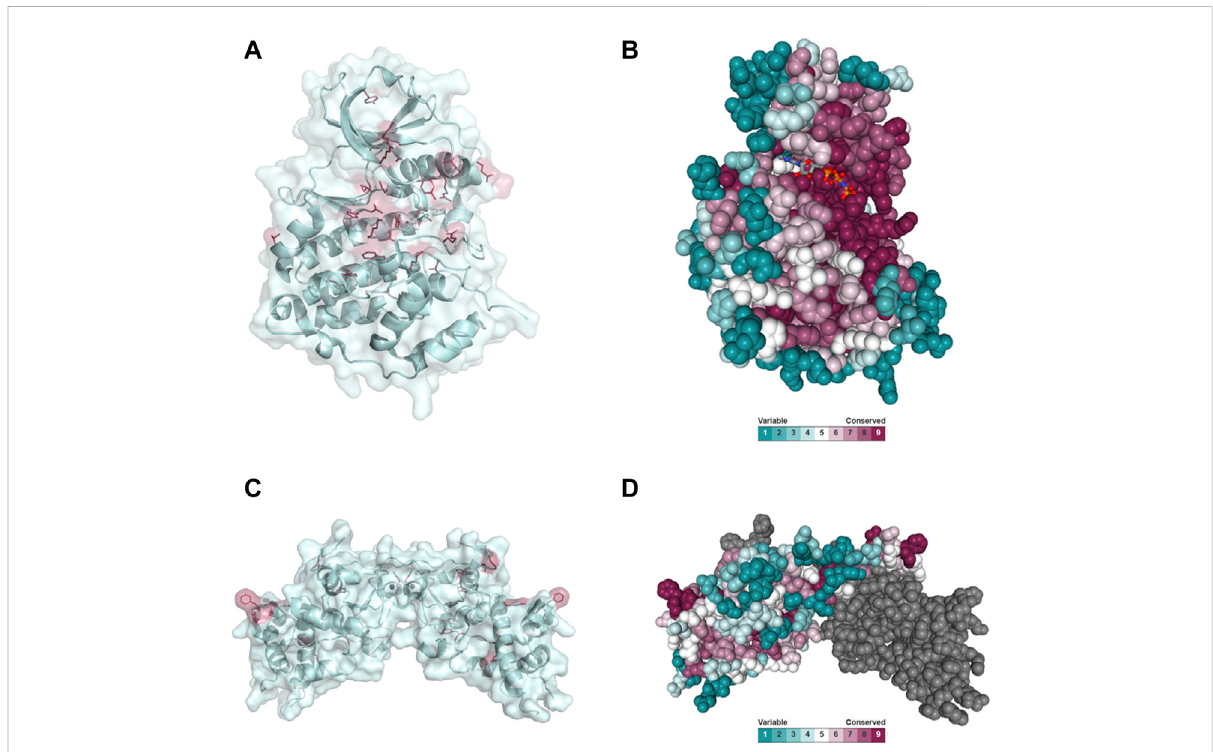
FIGURE 4 ConservedresiduesinCK2 α andCK2 β across150species. (A) General clustering ofthemutationsitesinCK2 α including surfacerepresentation. The structure of the CK2 α 1-335 monomer is shown as a pale cyan cartoon representation, the OCNDS related mutation sites are shown as sticks and are coloured raspberry red. The CK2 α 1-335 structure (PDB_ID: 2PVR (Nie fi nd et al., 2007)) was used for the fi gure. The fi gure was drawn using PyMOL (Schrödinger 2013). (B) Conserved residues of CK2 α . Conserved residues of CK2 α in space fi ll representation. The fi gure was created using the ConSurf server (Glaser et al., 2003; Landau et al., 2005; Ashkenazy et al., 2010; Celniker et al., 2013; Ashkenazy et al., 2016) with the CK2 α 1-335 structure (PDB_ID: 2PVR (Nie fi nd et al., 2007)). Multiple Sequence Alignment was built using MAFFT (Katoh et al., 2018). The Homologues were collected from UNIREF90 using the homolog search algorithm HMMER (Eddy 2011) (E-value: 0.0001; No. of HMMER Iterations: 1). As maximal identity between sequences 95% and as minimal identity for homologs 40% were chosen. The calculation was performed on a sample of 150sequences(seeSupplementaryDataSheetS3)thatrepresentthelistofhomologuestothequery.Conservationscoreswerecalculatedusingthe Bayesian method (Mayrose et al., 2004). (C) General clustering of the mutation sites in CK2 β including surface representation. The structure of the CK2 β 1-193 dimer is shown as a pale cyan cartoon representation, the mutation sites related to neurodevelopmental disability and epilepsy are shown